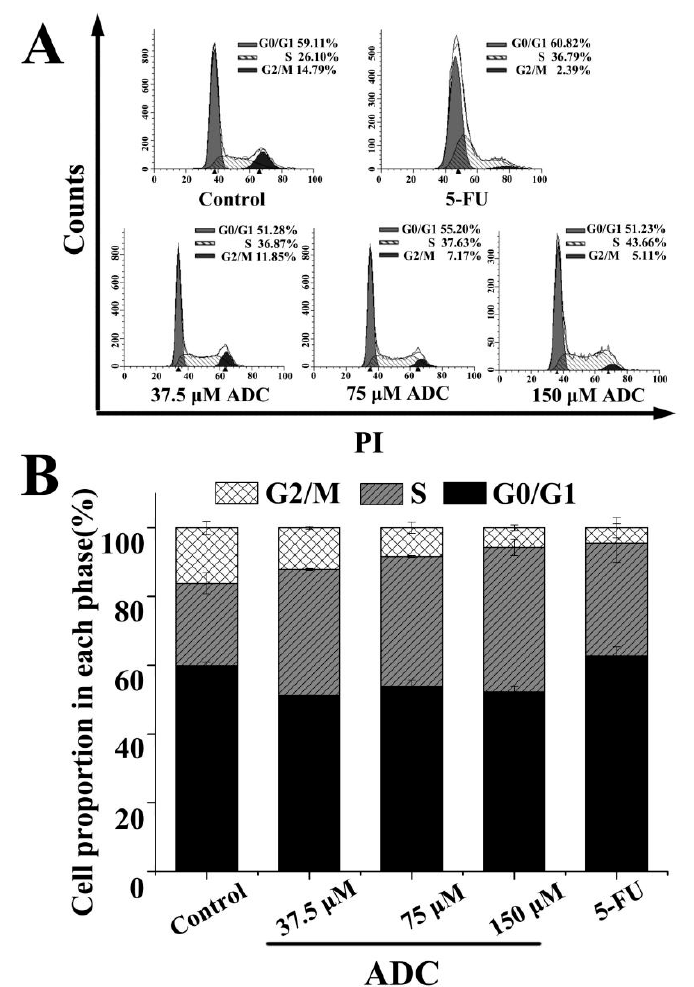
Figure 5. a fluorescence-activated cell sorter (FCAS) analysis of the cell cycle. ( A ) SPCA-1 cells were treated using 37.5, 75, and 150 µ M ADC for 72 h. 100 µ M 5-FU served as a positive control. The distribution of cell cycle, which was stained by PI, was analyzed using FCAS; ( B ) the percentage of cells in each phase of the cell cycles were calculated.